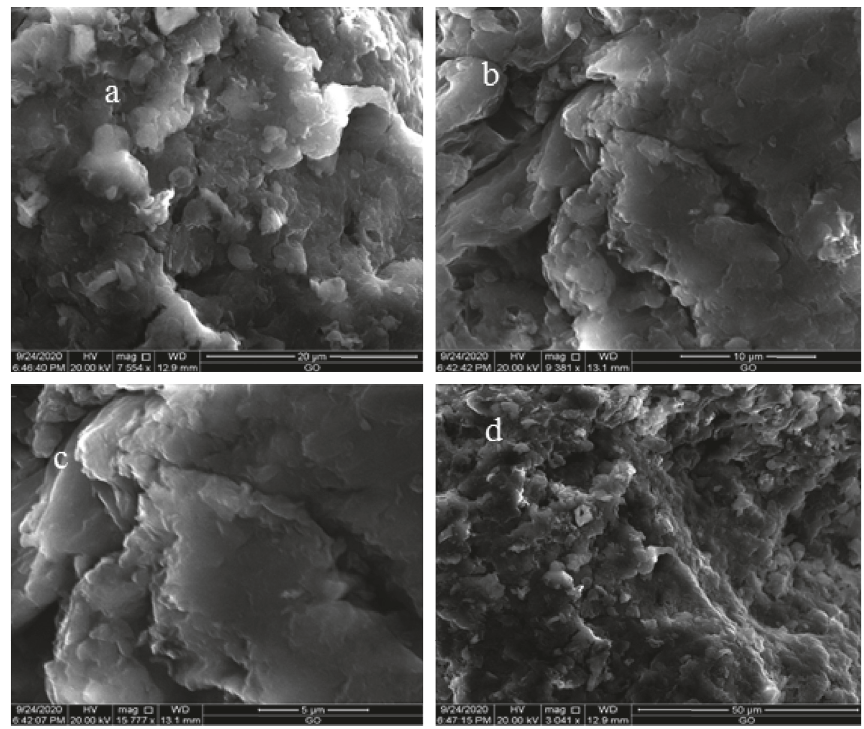
Figure 4: SEM morphology of GO.